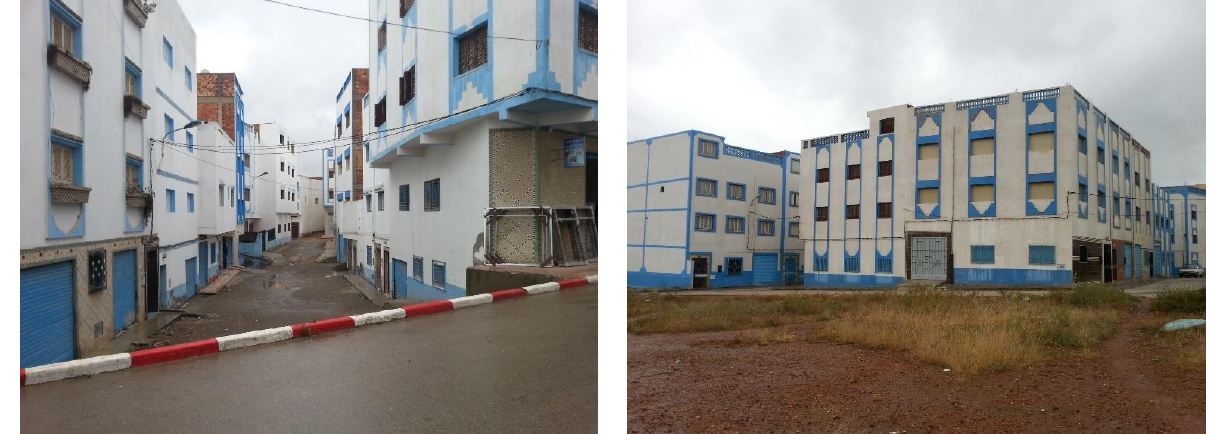
Figure 8. Examples of residential buildings in the study region.